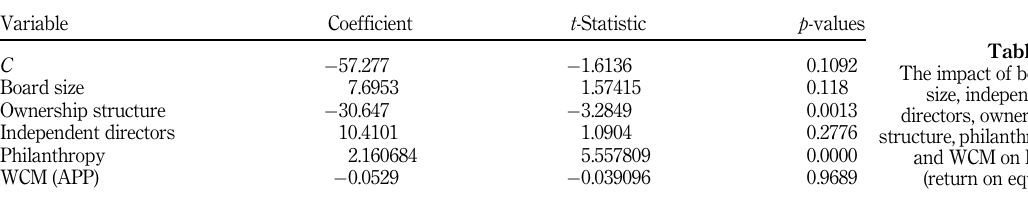
Table 2. The impact of